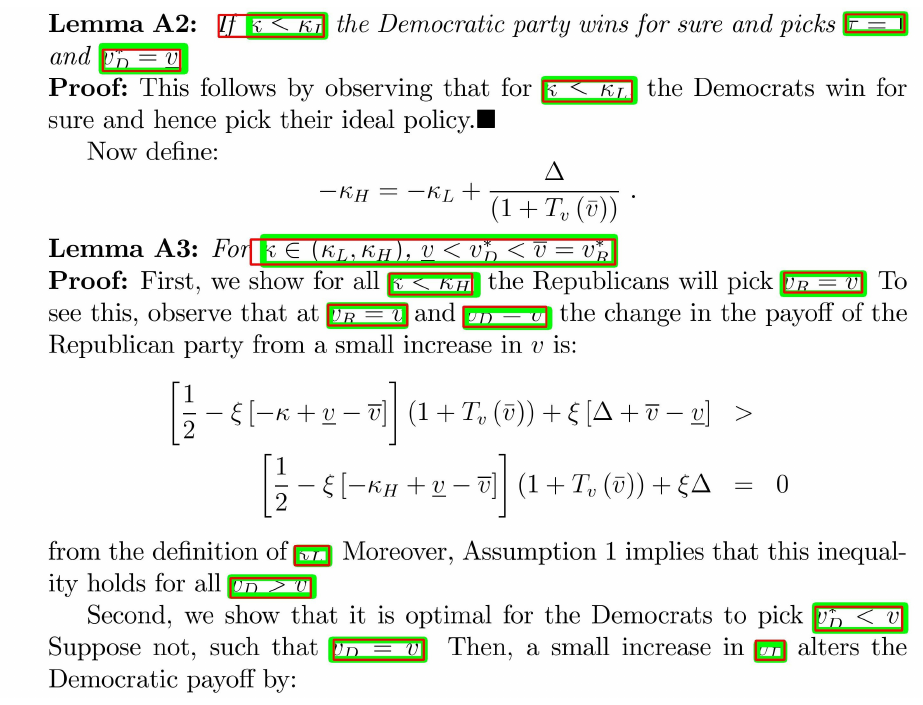
Figure 13. Instances of correct detections of embedded formulas in a document image taken from the Marmot dataset. The green color highlights the ground truth, whereas the predictions are marked with red color.